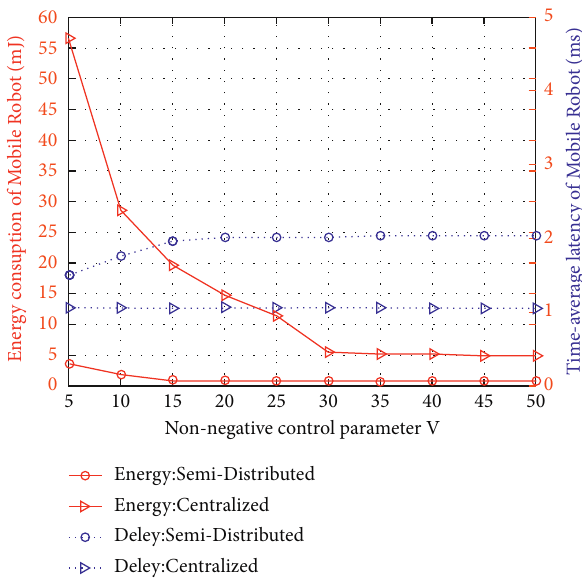
Figure 5: The performance between two different